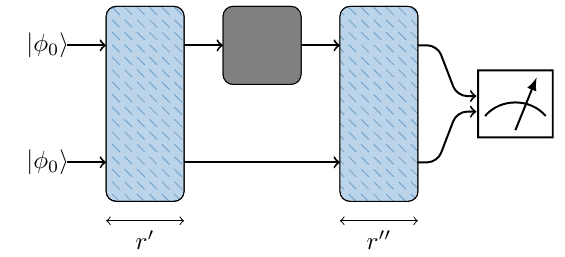
FIG. 3. Pictographic illustration of strong unitary complex- ity (Definition 3). A blackbox (center) takes quantum states as inputs and applies either a unitary channel U (ρ) = U ρ U † , or the depolarizing channel D (ρ) = ρ 0 = I / d . The task is to correctly guess which evolution occurred. The rules of the game allow short pre- and postprocessing circuits (blue line patterns) that may involve a quantum memory. The final guess must be based on a simple measurement (right). We say that U has complexity less than r = r (cid:2) + r (cid:2)(cid:2) if the probability of correctly distinguishing both options is close to